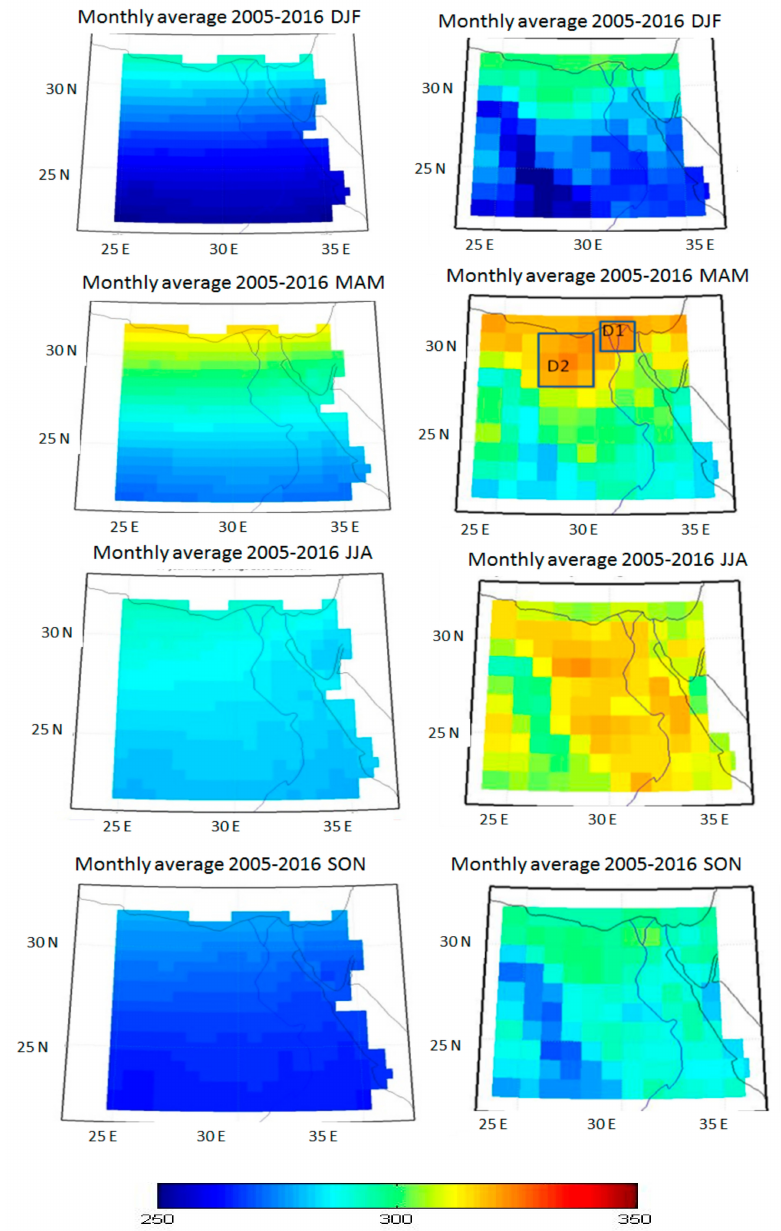
Figure 6. Seasonal average of TOC in (DU) over Egypt for winter (DJF), spring (MAM), summer(JJA) and fall (SON), for the period (2005–2016). Two domains, D1 and D2, are shown for further analysis on MAM map for MERRA-2 ( left panel ) and AIRS ( right panel